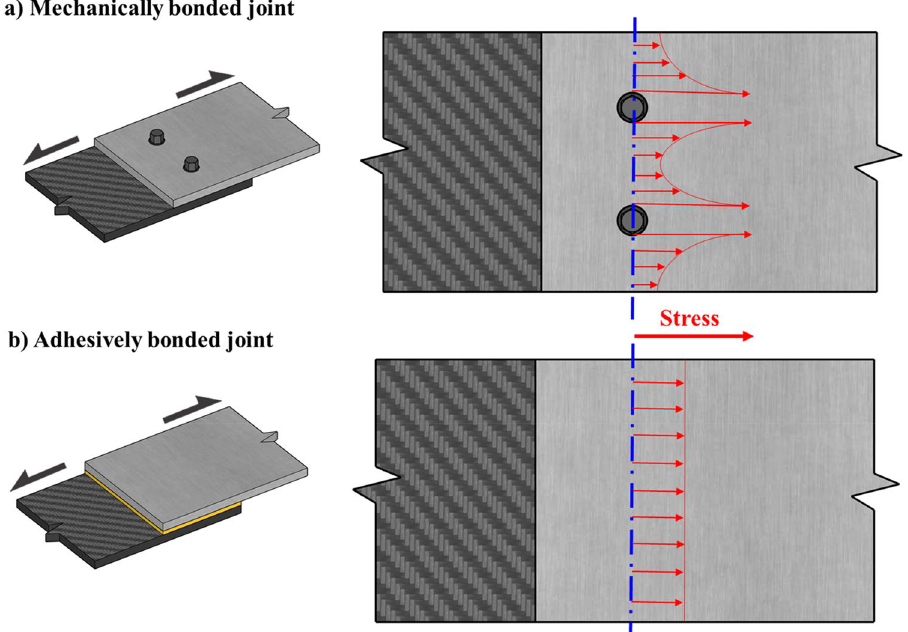
Fig. 2 A comparison between the stress distribution of a mechanical bonded joint, and b adhesively bonded